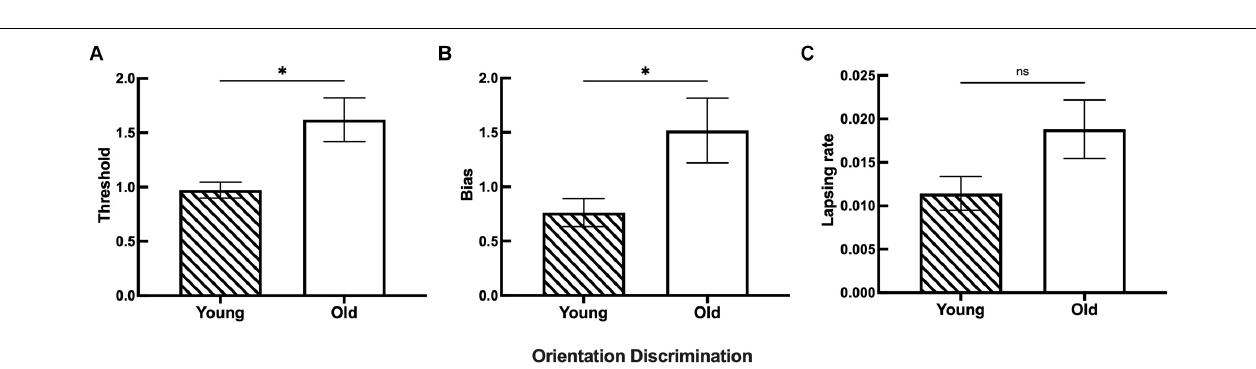
FIGURE 4 | The discrimination ability difference of orientation between the young and old groups. (A) Statistical results showing the threshold differences between the young ( n = 26) and old ( n = 26) groups. (B) Statistical results showing the bias differences between the young ( n = 28) and old ( n = 27) groups. (C) Statistical results showing the lapsing rate differences between the young ( n = 28) and old ( n = 25) groups. Data are expressed as mean ± SEM. * p < 0.05 for the young group and the old group in the threshold and bias. ns indicates no significant difference between the young and old group in the lapsing rate analysis.